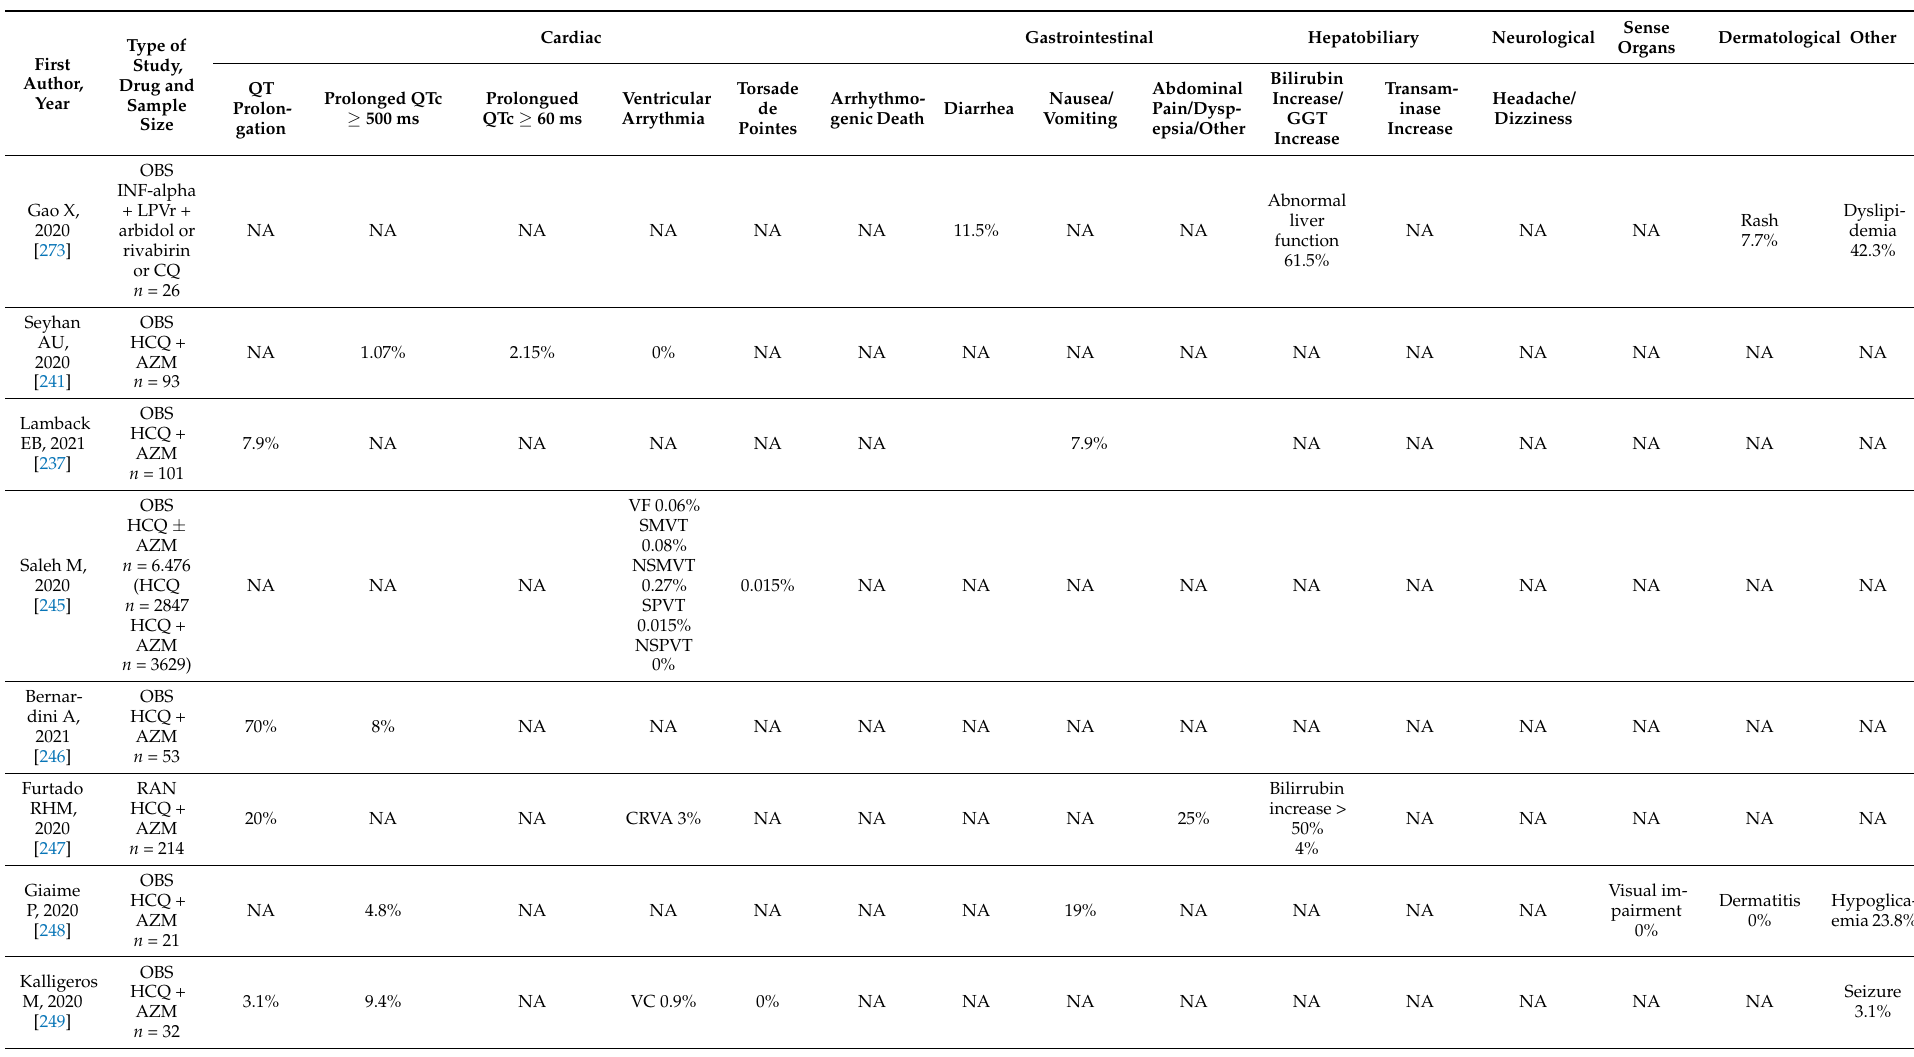
Table 8. Adverse effects of CQ or HCQ in combination with other drugs used to treat COVID-19 reported in observational and randomised